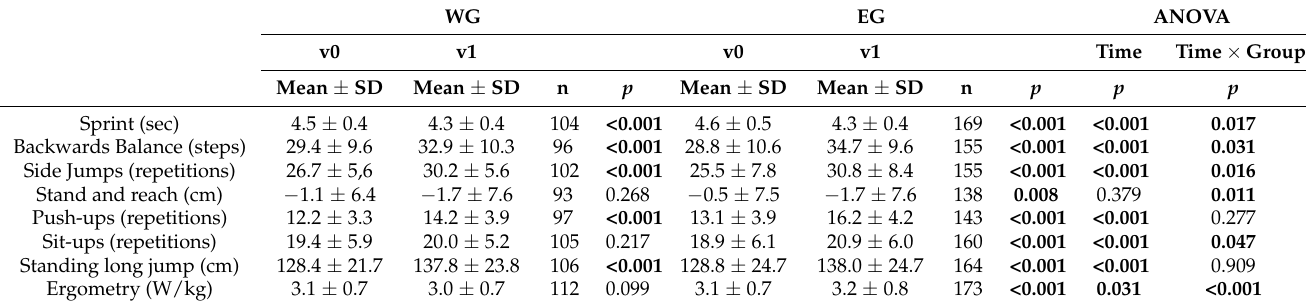
Table 2. Univariate within- and between-group analysis of the change in motor skills after one year. WG EG